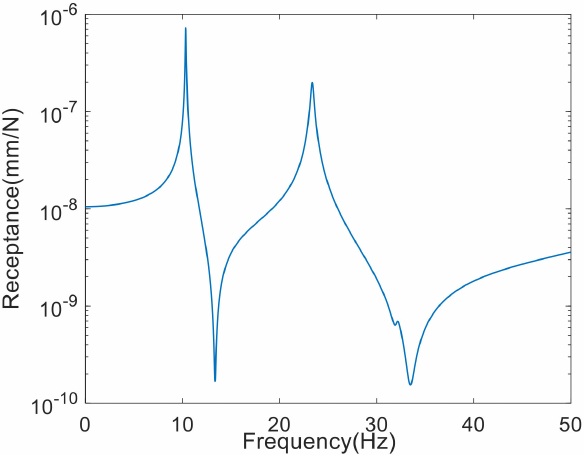
Figure 3. Receptance curve of the truss